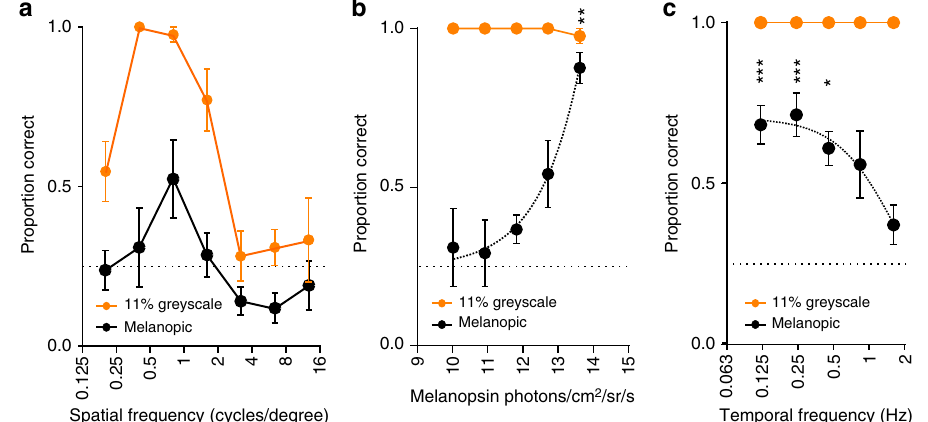
Fig. 3 De fi ning the sensitivity limits of melanopsin form vision. a Proportion of correctly identi fi ed stimuli at spatial frequencies from 0.2 to 12.8 cpd using individually calibrated melanopic (black) and 11% greyscale stimuli (orange) with stimuli attenuated by ~4000 (mean luminance 0.054 cd/m 2 ; black edged circles). Repeated measures one-way ANOVAs showed signi fi cant effect of spatial frequency for greyscale ( p < 0.001) but not melanopic stimuli ( p = 0.09). For melanopic stimuli, no responses at ND4 were signi fi cantly different from 0.25 (one-sample t -test). Data show mean ± SEM; n = 7. b Irradiance response function for melanopic (black) and 11% greyscale stimuli (orange) for 0.4 cpd stimuli. A repeated measures one-way ANOVA showed signi fi cant effect of intensity for melanopic stimuli ( p < 0.001). Responses were compared using a one-sample t -test with a mean of 0.25 (chance point. ** p < 0.01). Data show mean ± SEM; n = 7. Where no error bars are plotted, all participants were correct in 100% of trials. c Proportion of correctly identi fi ed stimuli presented at temporal frequencies of 0.125 – 2.5 Hz (spatial frequency of 0.4 cpd) using individually calibrated ‘ melanopic ’ stimuli (black) and 11% greyscale stimuli. A repeated measures one-way ANOVA showed signi fi cant effect of temporal frequency for melanopic stimuli ( p < 0.05). Responses were compared using a one-sample t -test with a mean of 0.25 (chance point); for melanopic stimuli: * p < 0.05; *** p < 0.001. Data show mean ± SEM; n = 5. Where no error bars are plotted, all participants were correct in 100% of